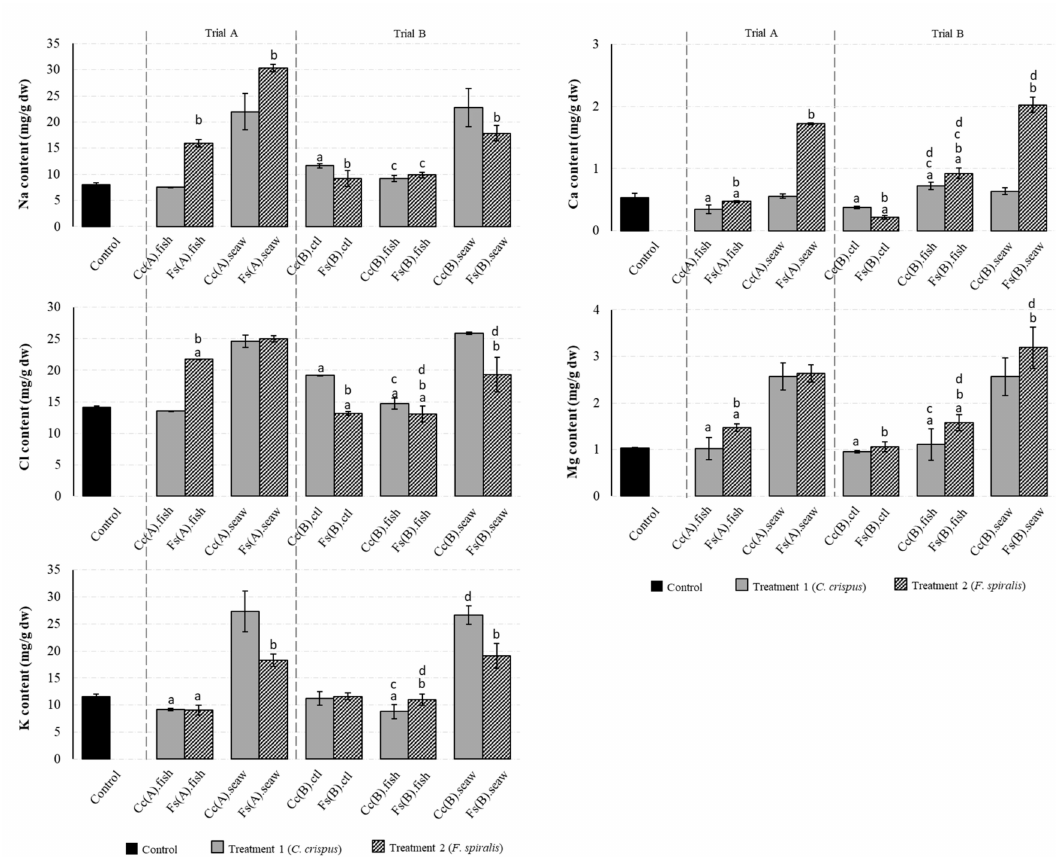
Figure 2. Macroelements composition (mg / g dw) of canned chub mackerel produced under the traditional process (Control) and incorporating C. crispus (Treatment 1—Trial A and B) or F. spiralis (Treatment 2—Trial A and B) seaweed species. Data represent the mean ± SD of six canned samples, analysed in duplicate. Statistical significance was determined by the Tukey’s post hoc test at: a p < 0.05 versus the Control sample; b p < 0.05 versus respective sample (fish / seaweed) obtained in Treatment 1 (in Trial A and B); c p < 0.05 versus Cc(B).ctl or Fs(B).ctl obtained in Treatment 1 and 2 (in Trial B), and d p < 0.05 versus respective fish sample (Cc(A).fish, Fs(A).fish) or seaweed sample (Cc(A).seaw or Fs(A).seaw) obtained in Treatment 1 and 2 (in Trial